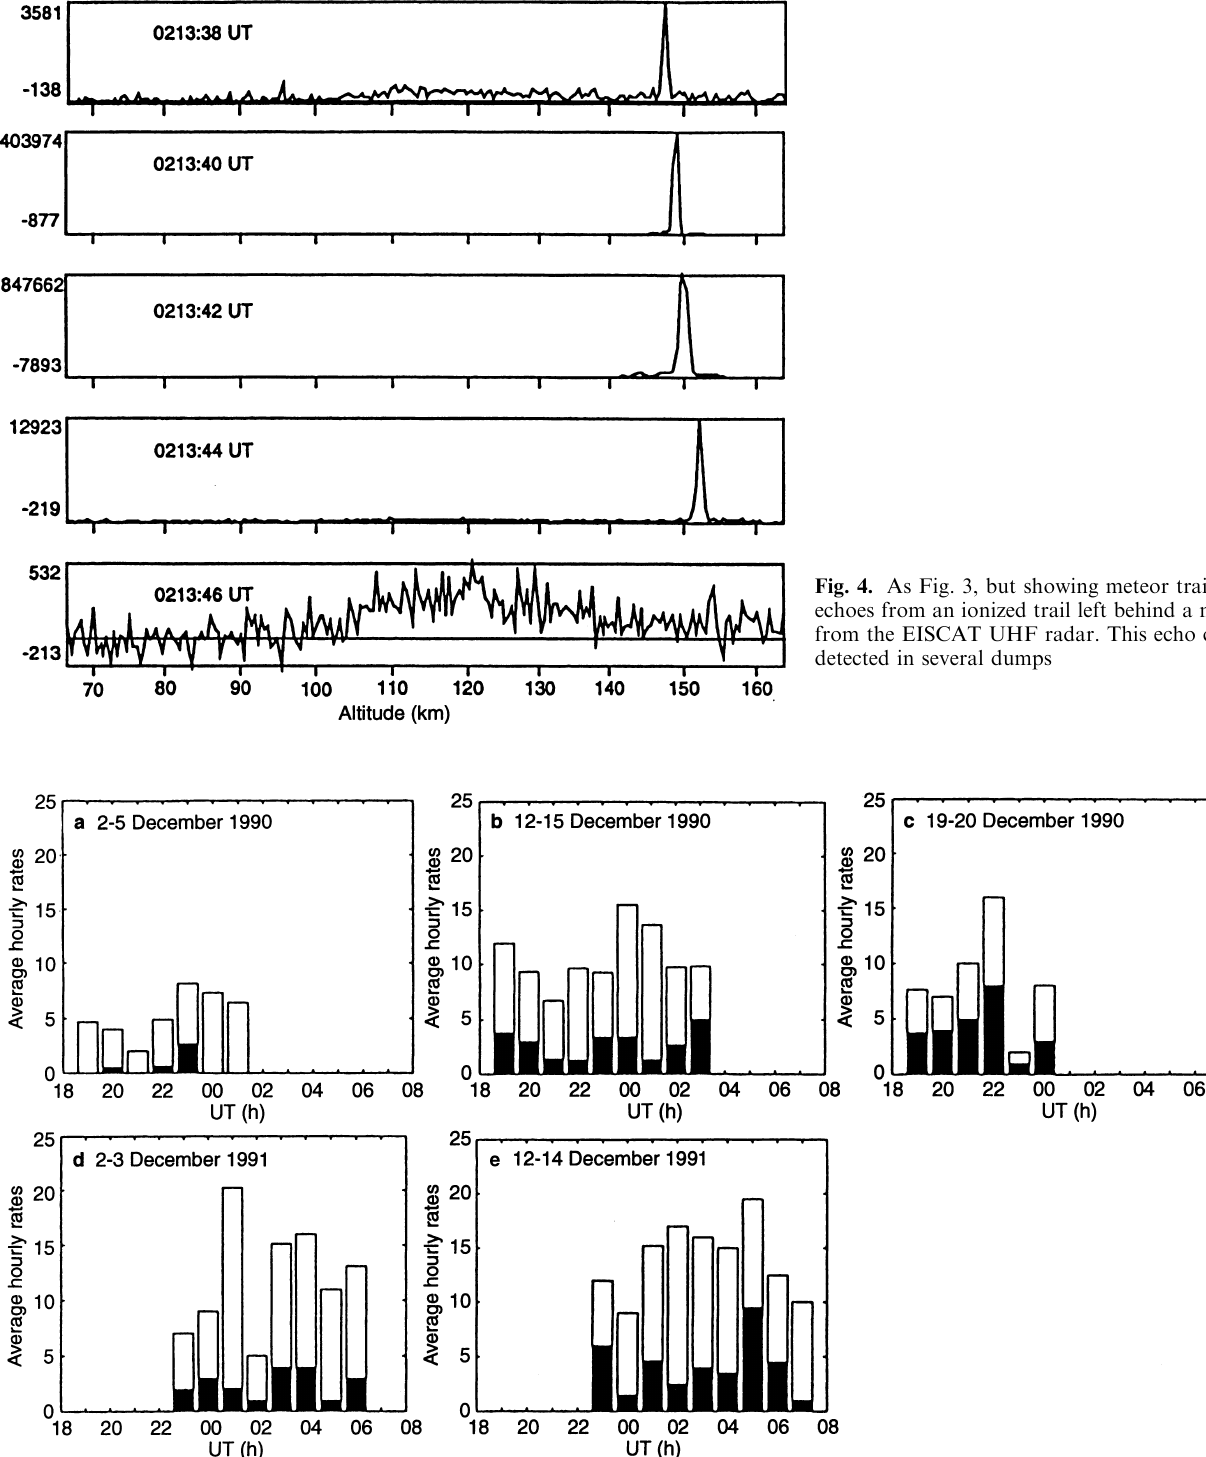
Fig. 5. Average hourly meteor trail ( black ) and head ( white ) echo rates from di(cid:128)erent periods of the Geminid campaigns in 1990 and 1991. The data are taken with the UHF radar.